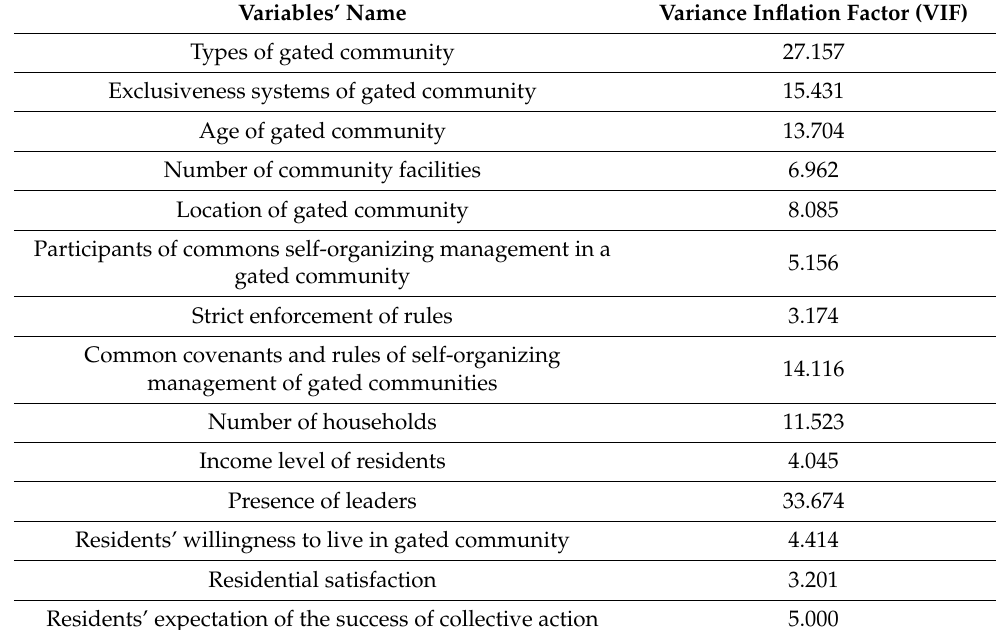
Table 6. Variance inflation factor